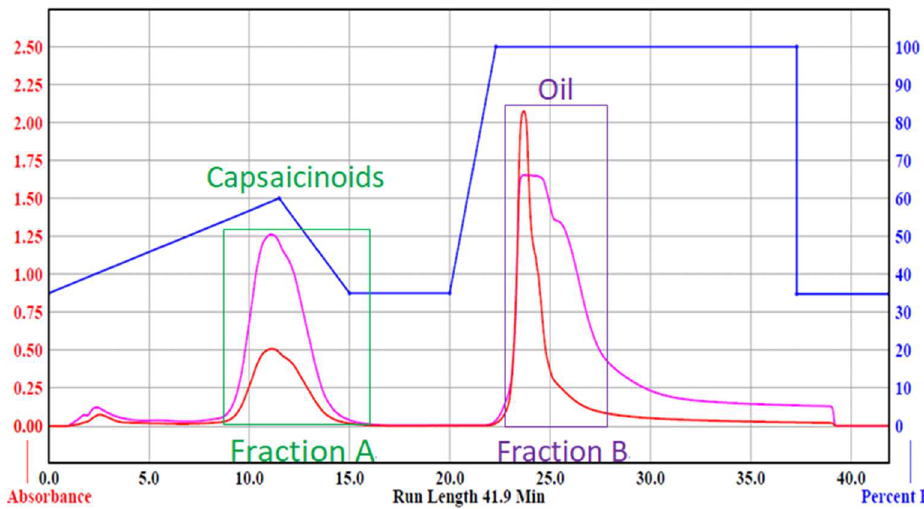
Figure 4. Chromatograms of capsaicinoids (Fraction A) and no-heat red pepper oil or NHRPO (Fraction B). The blue line indicates the percentage of ethanol in the aqueous mobile phase. The pink and red lines indicate the UV absorptions at 228 nm (for detection) and 300 nm (for monitor- ing), respectively.